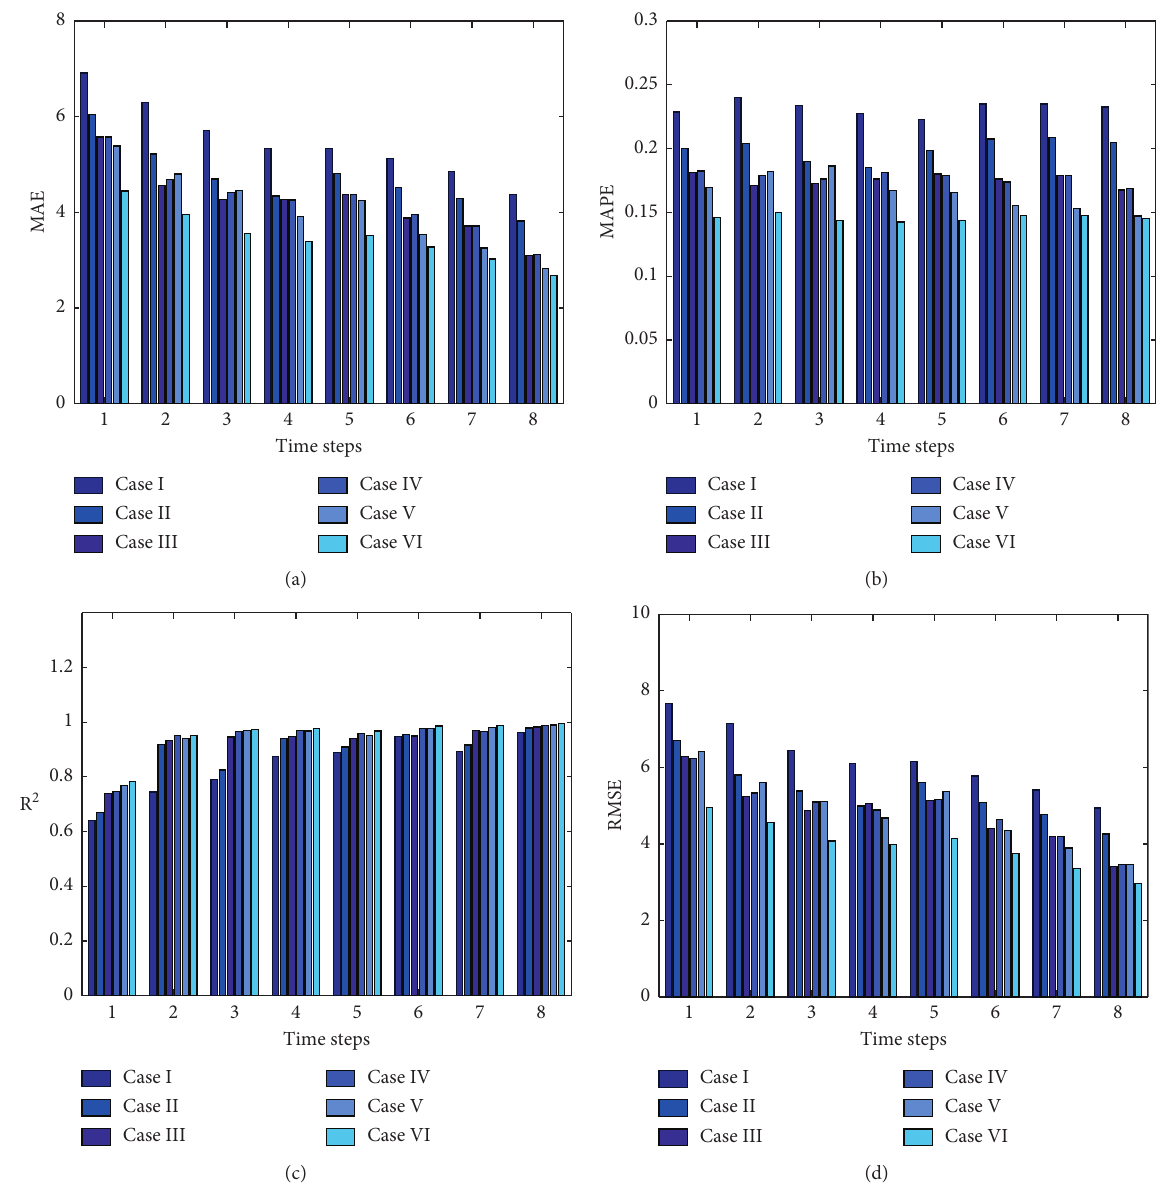
Figure 7: Prediction errors with different input